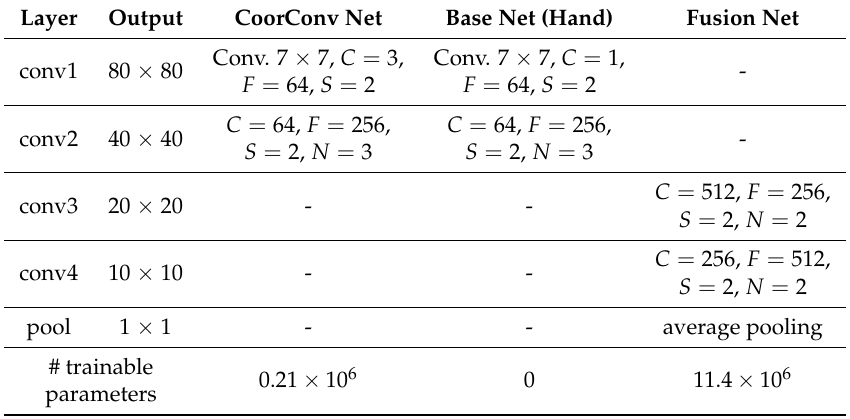
Table 1. Architecture details of the three CNN networks used in our multi-stream RNN. C , F , S , and N correspond to the # of input channels, # of filters, stride, and # of building blocks in the layer. The output size of feature maps is based on the input frame resized to 160 × 160